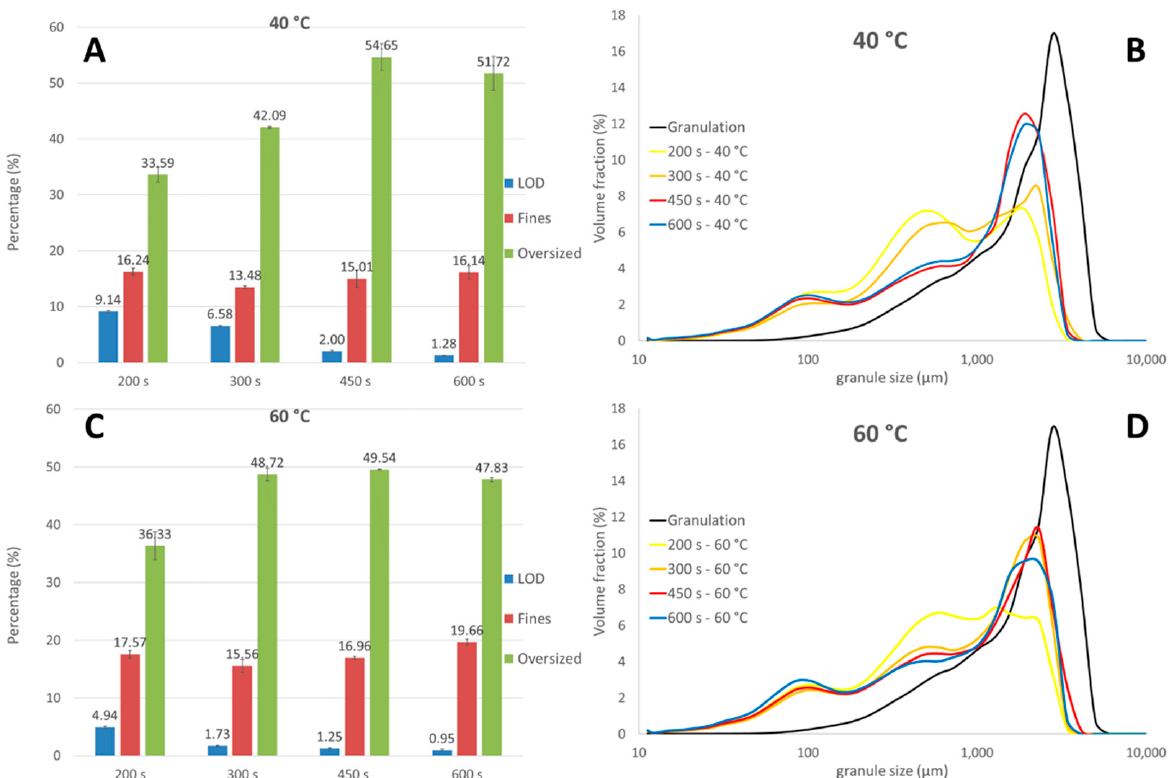
Figure 6. The fraction in fines and oversized granules and the corresponding overall moisture content after different drying times for granules collected after the conditioning unit at 40 ( A ) and 60 °C ( C ). Granules size distributions to visualize the effect of drying time at 40 ( B ) and 60 °C ( D ).